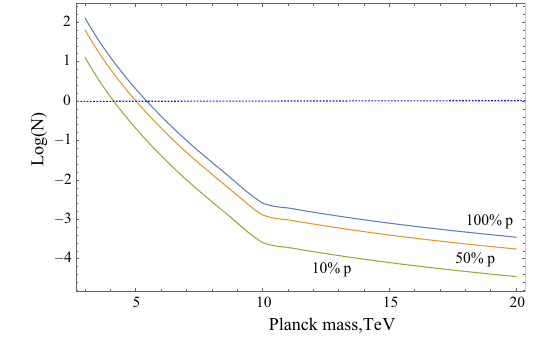
Fig. 6 The amount of the neutral black holes, stopped by a neutron star with a radius 10 km during 10 10 year, the cosmic ray energy is E < 5 · 10 19 eV, for the different cosmic ray composition: 100% p, 50% p, 10%